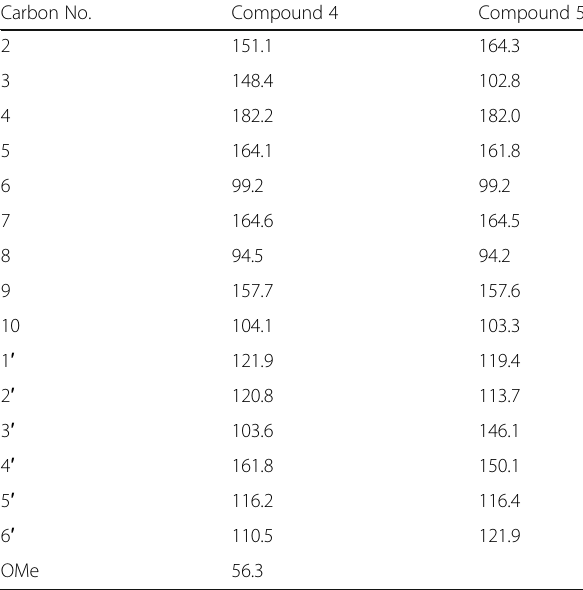
Table 3 13 C-NMR spectral data of AI 4~5 (DMSO- d 6